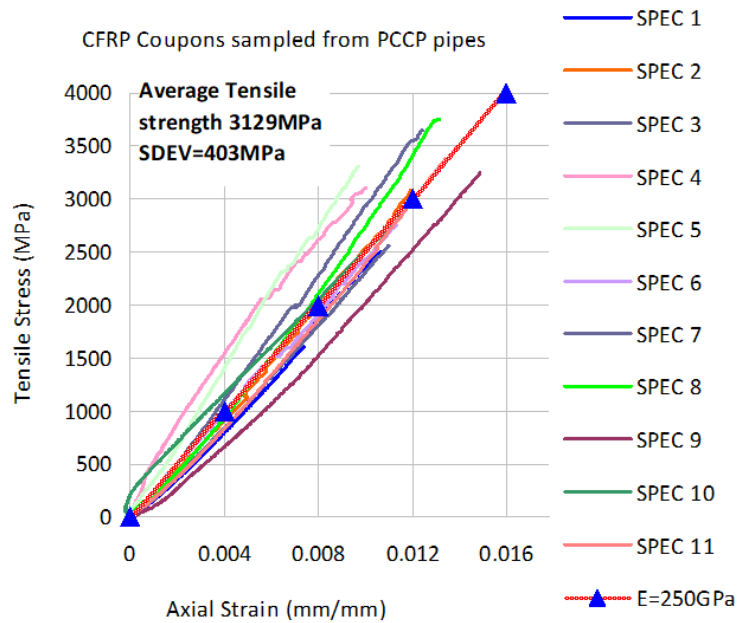
Figure 6. Tensile behaviour of CFRP specimens taken from the tested PCCP pipes. The sprayed RC jacket was constructed by first placing 18 mm diameter longitudinal reinforcing bars, spaced every 300 mm, just above the prestressing wires. Radial closed-ring reinforcing bars of 14 mm diameter, spaced at 95 mm intervals, were next placed in contact with the longitudinal reinforcement. Both the longitudinal and radial reinforcing bars were secured in place by 250 mm diameter spacers resting on the surface of the prestressing wraps. The special concrete mix was sprayed uniformly all around the periphery of the specimen, providing a new concrete layer with a thickness approximately equal to 50 mm. The quality of this layer of sprayed concrete is C40 with a compressive strength equal to 40 MPa. The reinforcing bars of this external sprayed concrete jacket were of B500C quality, with nominal yield stress equal to 500 MPa. The tensile behaviour of the radial 14 mm diameter reinforcing bars of this RC external jacket (shown in Figure 7) was found by testing coupons taken from these jackets following the internal pressure test of the relevant pipes. Table 2 lists all of the geometric details, together with the most important mechanical properties of all materials involved. Figures 8–10 depict the cross-section details of the used alternative repair-strengthening schemes that were investigated in the framework of this